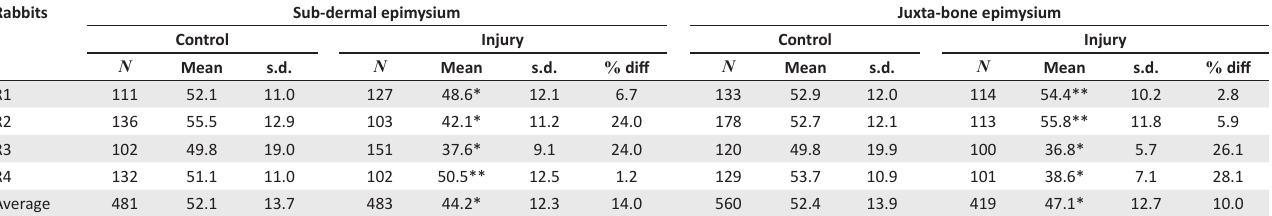
TABLE 2: Cross-sectional diameters (in μ m) of myofibres in sub-dermal and juxta-bone biopsies from control and injured vastus lateralis muscle from Rabbits 1–4 expressed as mean and one standard deviation. Rabbits Sub-dermal epimysium Juxta-bone epimysium Control Injury Control